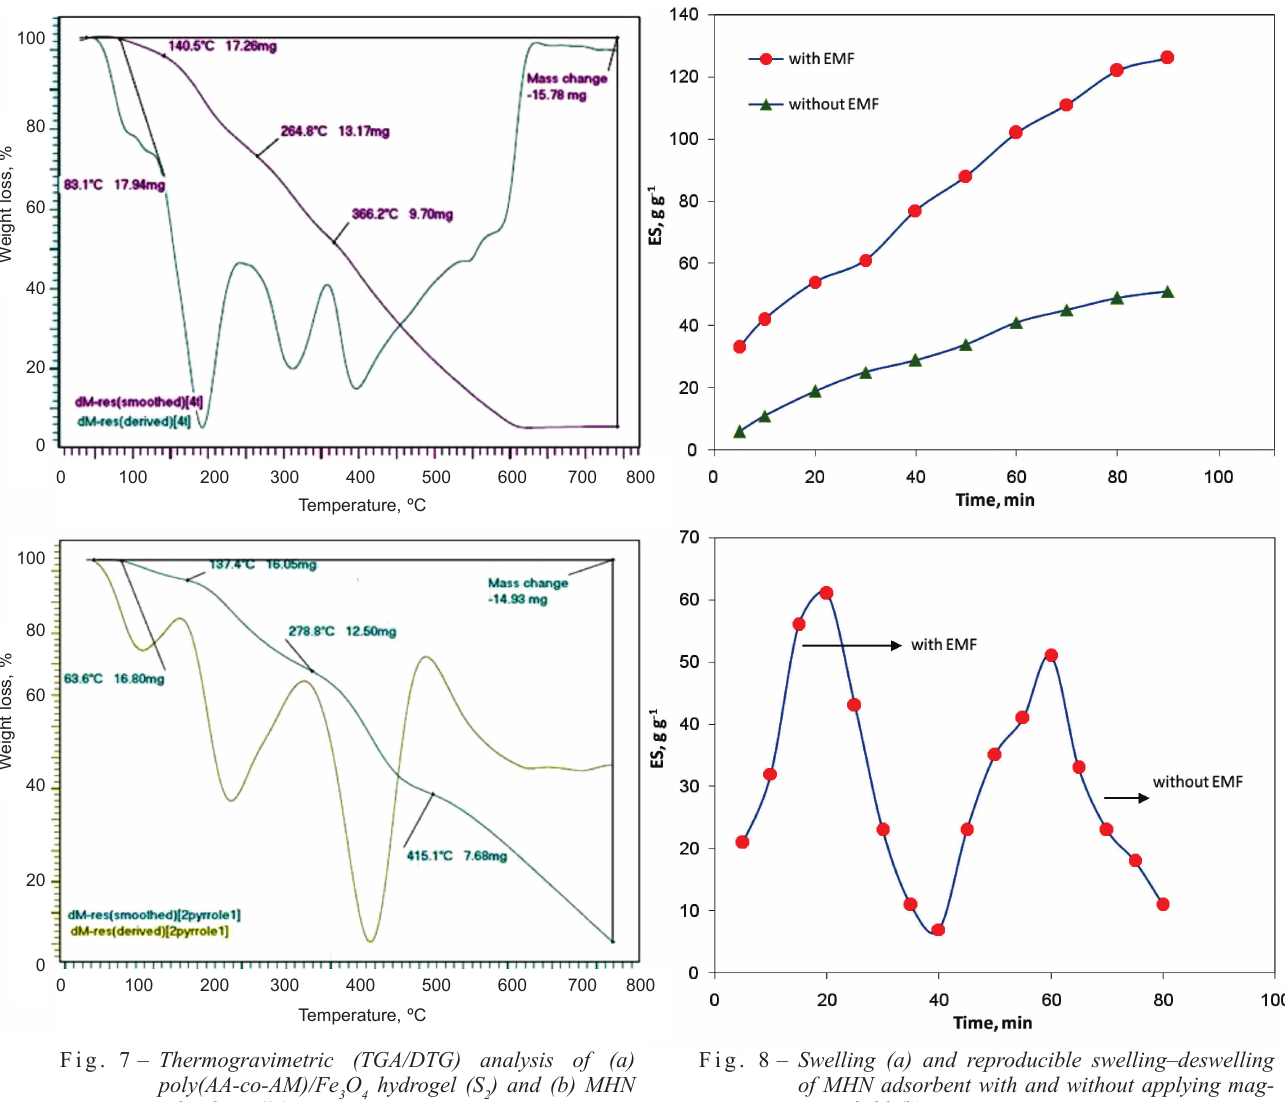
Fig. 7 – Thermogravimetric (TGA/DTG) analysis of (a) poly(AA-co-AM)/Fe